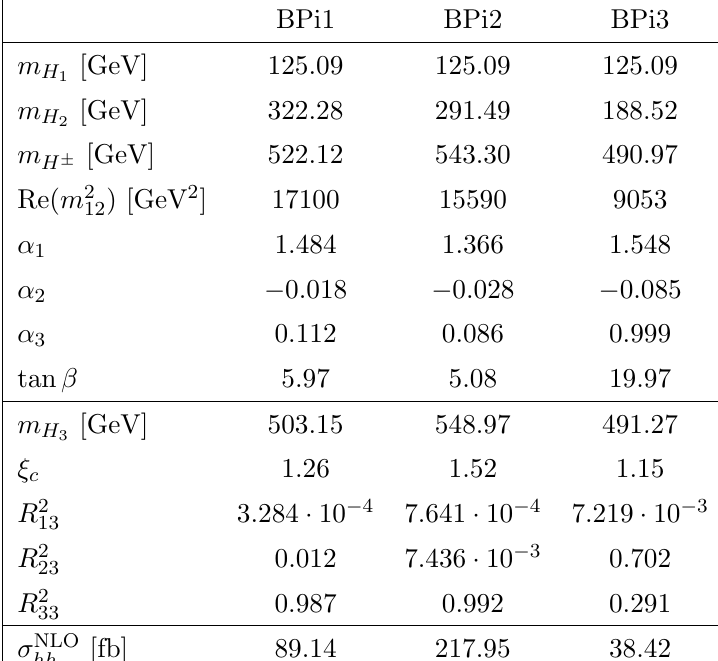
Table 2 . Line 1-8: the input parameters of the benchmark points BPi1-3. Line 9 to 13: the derived 3rd neutral Higgs boson mass, the (cid:24) c value and the CP-odd admixtures R 2 QCD gluon fusion hh production cross section at p s = 14 TeV.